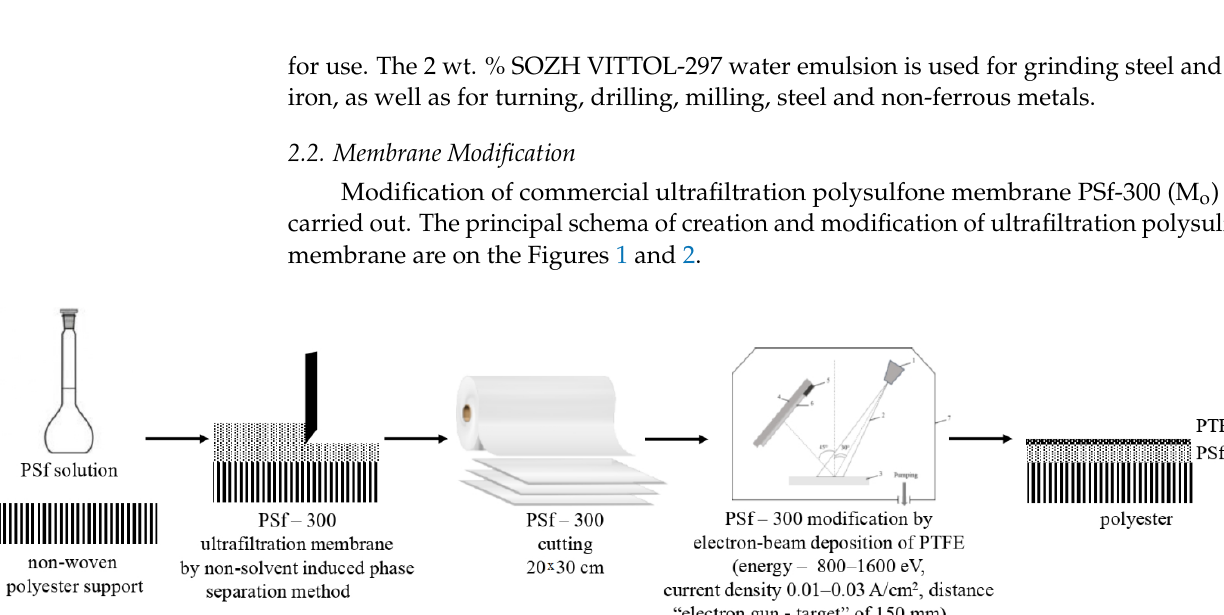
Membranes 2022 , 12 , x FOR PEER REVIEW